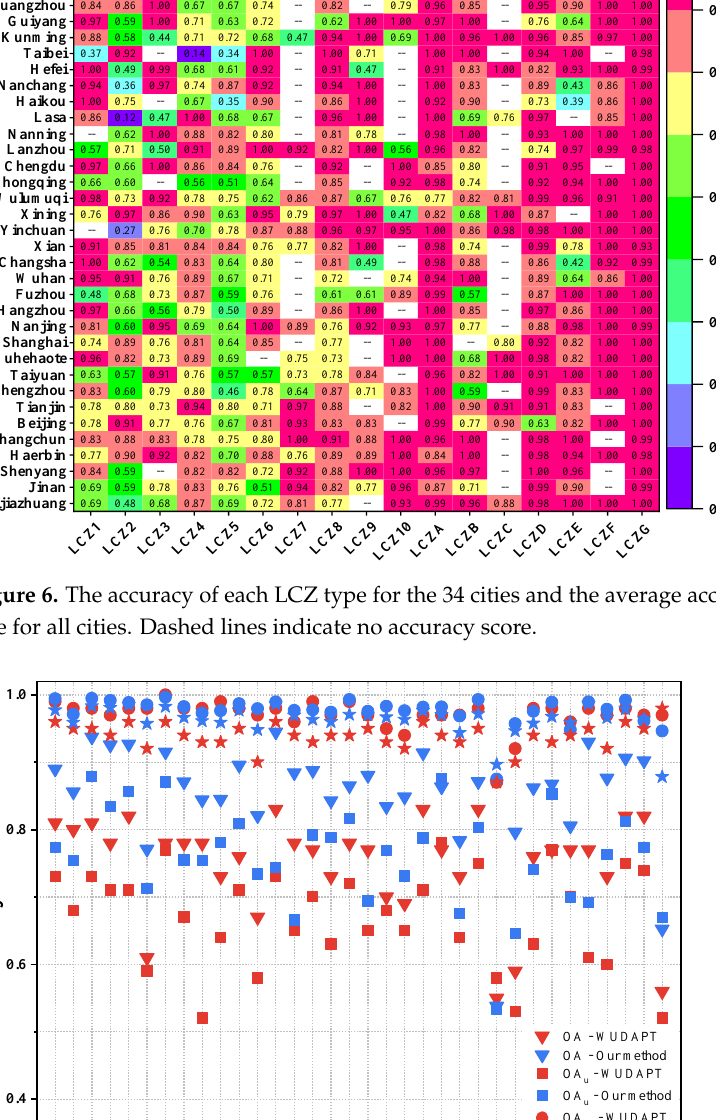
Figure 6. The accuracy of each LCZ type for the 34 cities and the average accuracy is given at the top line for all cities. Dashed lines indicate no accuracy score.